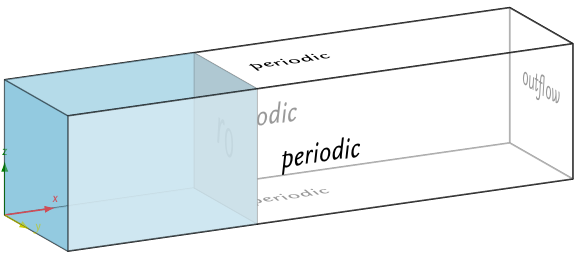
Figure 3. Geometry setup for the simulations in Section